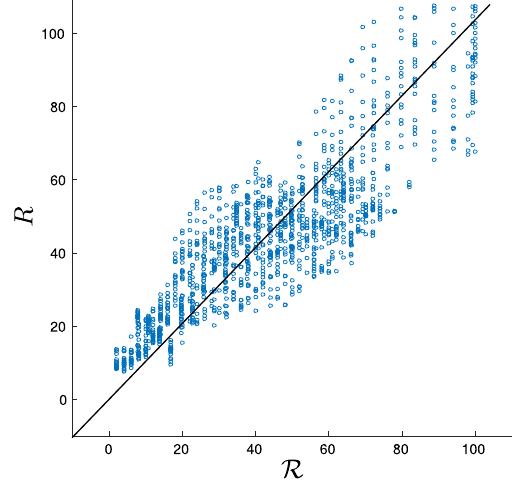
Fig. 10 Plot showing the compression ratio R predicted using Eq. 24 versus the ‘‘true’’ compression ratio R . The data are obtained from a set of validation